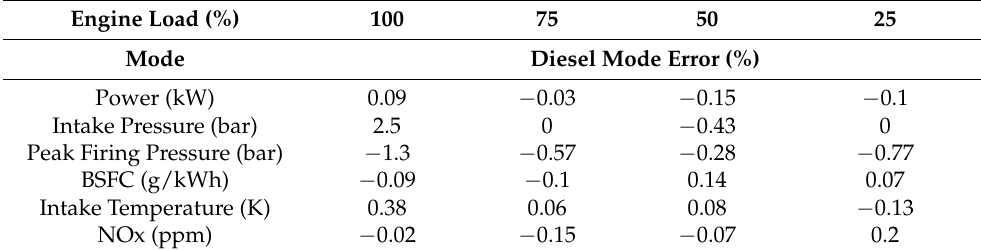
Table 4. Calculation error of the diesel mode.